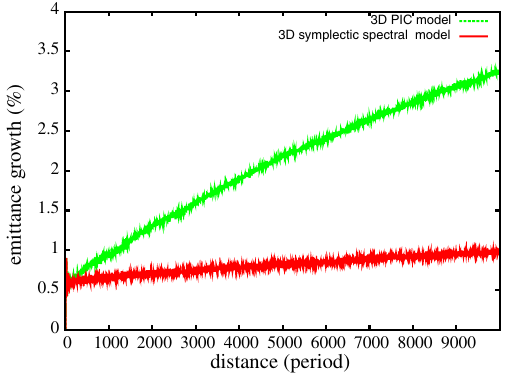
FIG. 10. Parallel speedup of the 2D and the 3D symplectic tracking models on a Cray XC30 computer.